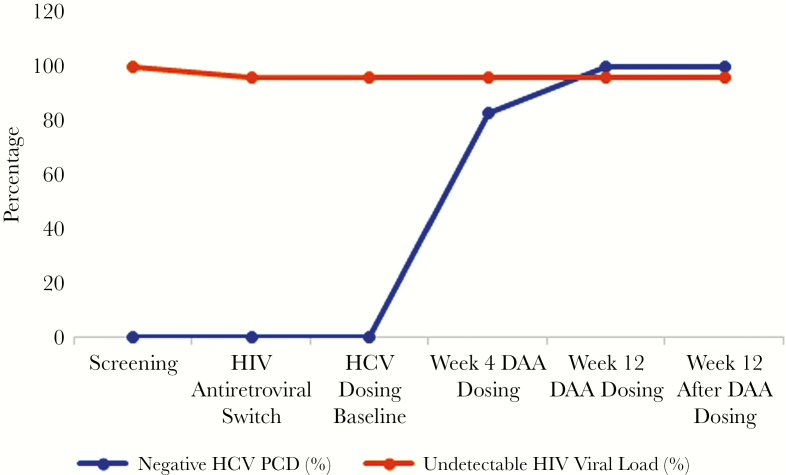
Percentage of patients with participants with negative HCV RNA and an undetectable HIV viral load at screening, baseline, and throughout the study period. Abbreviations: DAA, direct-acting antivirals; HCV, hepatitis C virus; PCR, polymerase chain reaction.